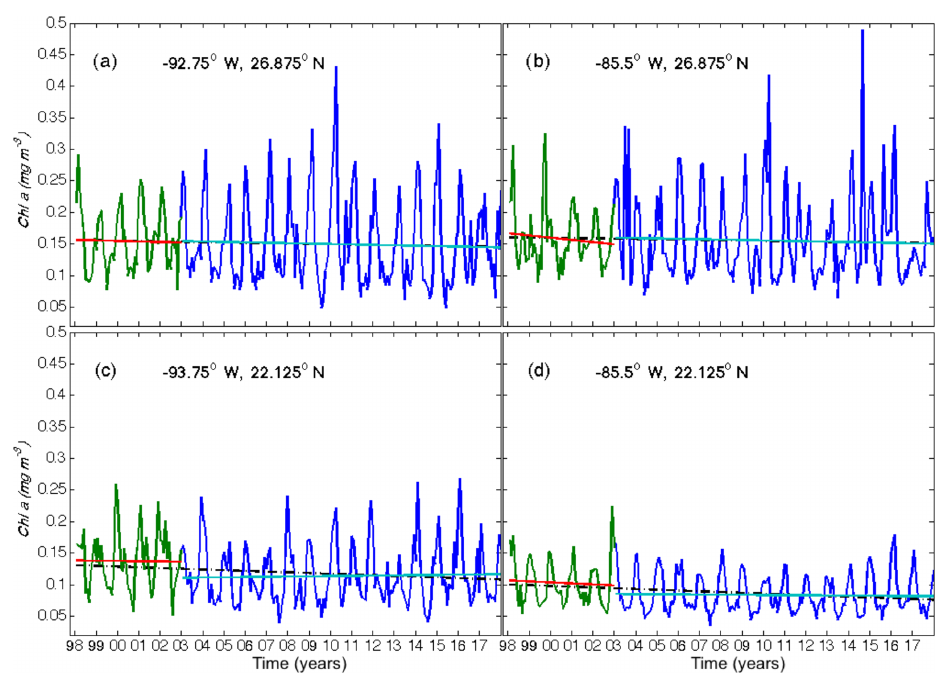
Figure 11. Chl a concentrations (mgm − 3 ) at four stations ( a to d ) in the GoM; daily time series derived from SeaWIFS from 1998 to 2002 (green) and MODIS from 2003 to 2017 (blue). Least squares regressions for SeaWIFS (red line), MODIS (cyan line), and the overall linear regressions for each station (dashed black